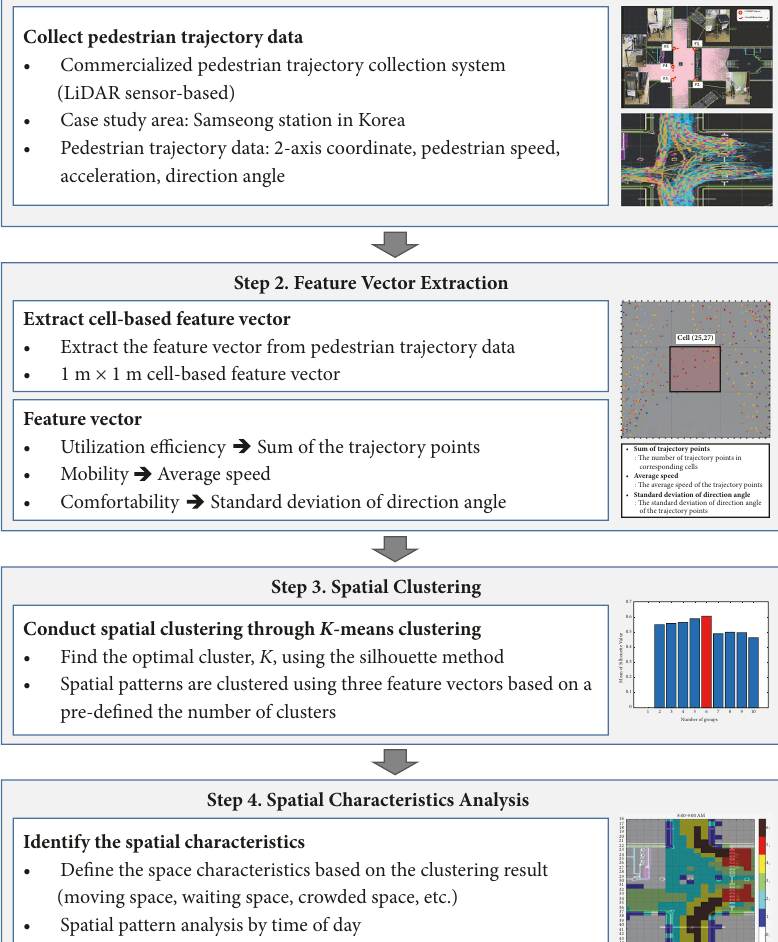
internal algorithm. The algorithm is provided by the commercialized system based on the raw data collected from the LiDAR